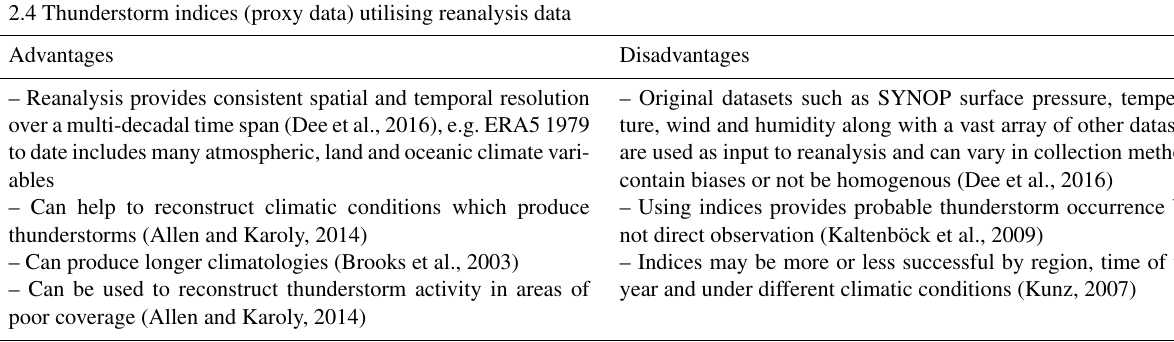
Table 4. Strengths and weaknesses of proxy datasets used to produce thunderstorm and lightning